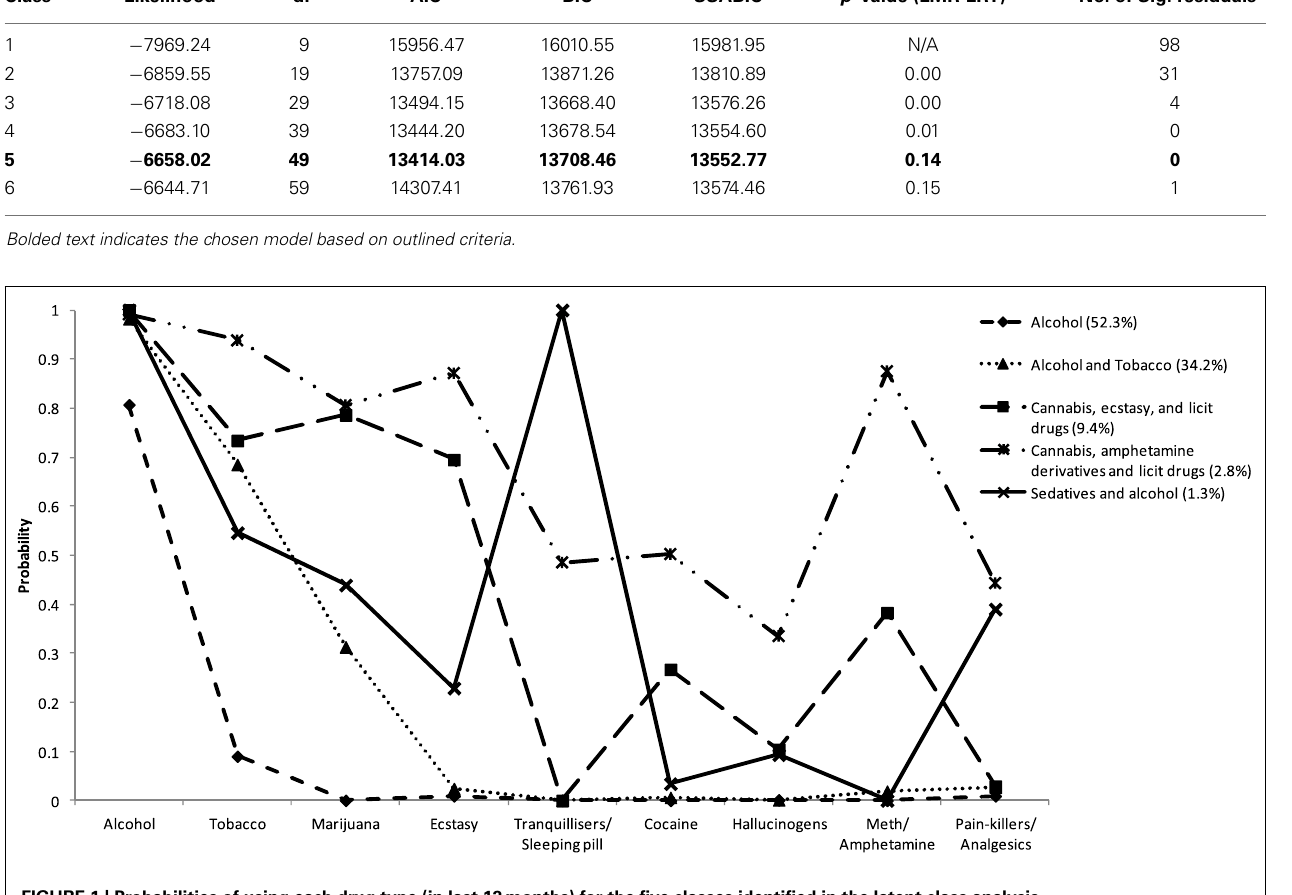
FIGURE 1 | Probabilities of using each drug type (in last 12months) for the five classes identified in the latent class analysis